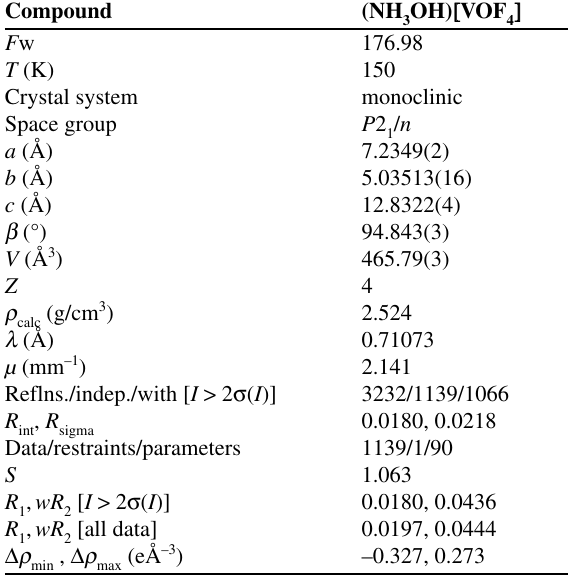
Table 1. Crystal data and structure refinement